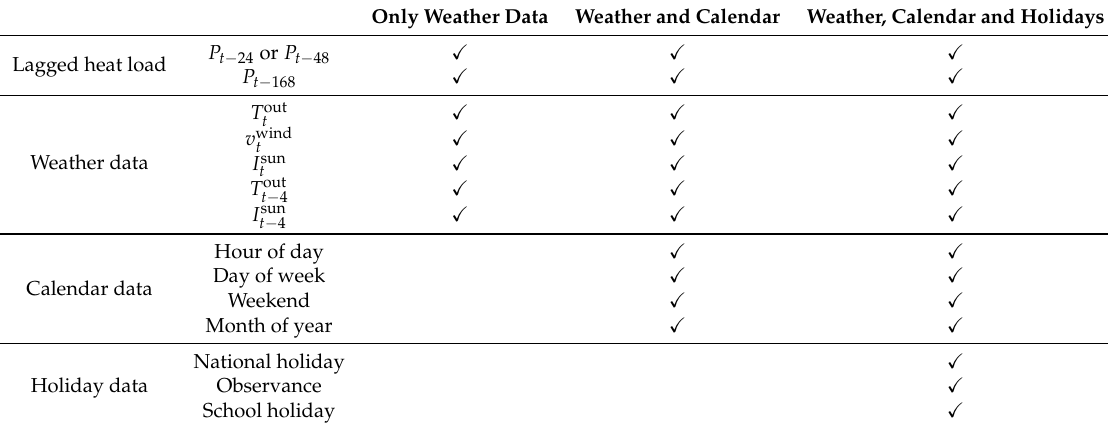
Table 1. Input variables used in the three data scenarios (in